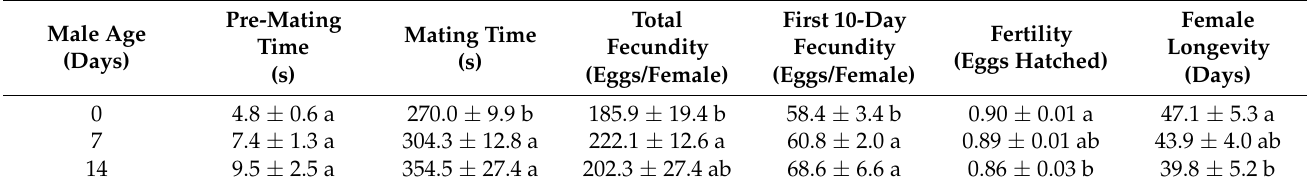
Table 3. Effect of male age at mating on mating time, fecundity, fertility and longevity of O. laevigatus